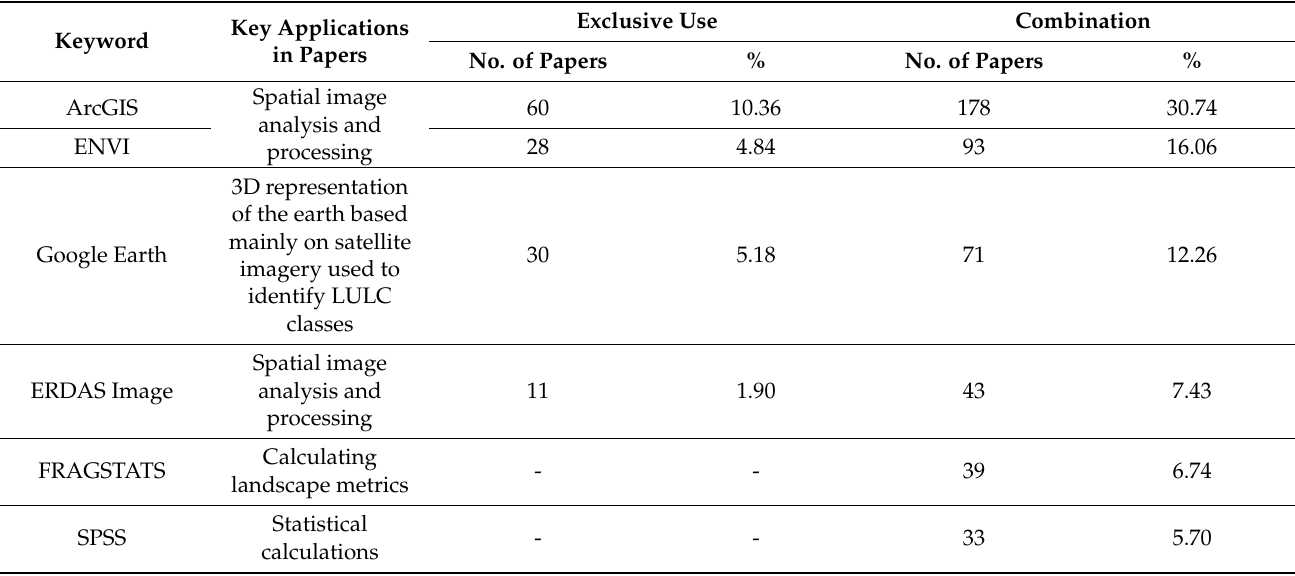
Table 8. Six most used software programs.